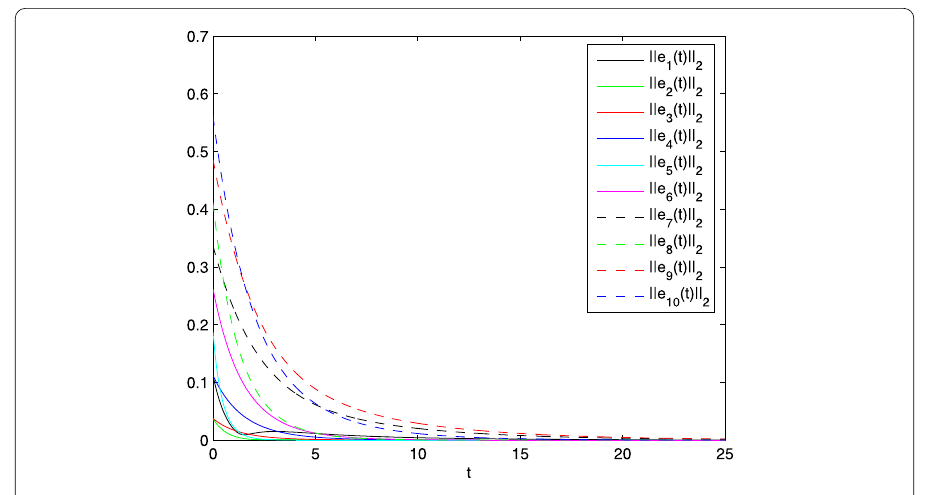
Figure 9 The synchronized error (cid:2) e i ( t ) (cid:2) 2 , i = 1,...,10, of system (32) under pinning control (3).